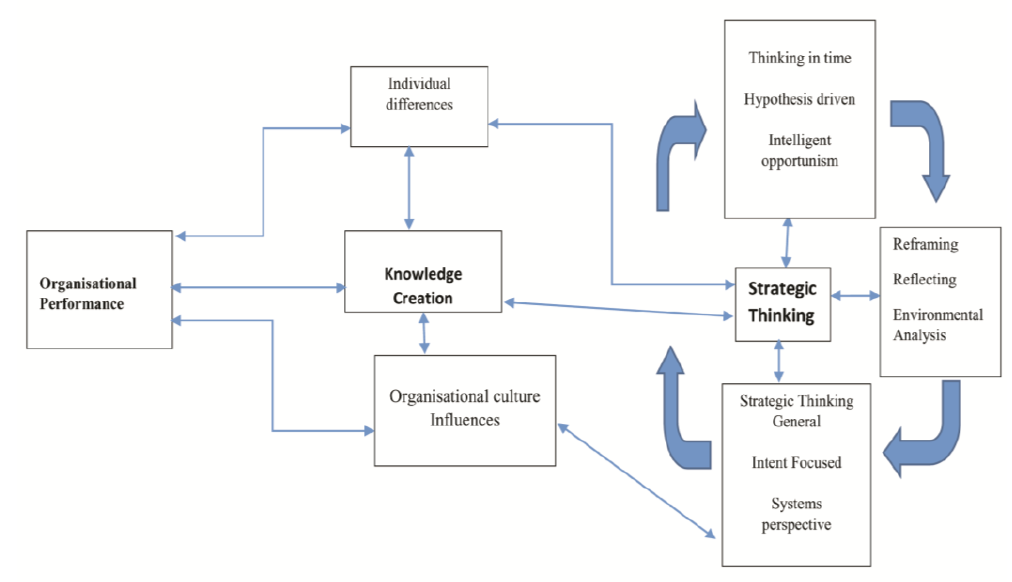
Figure 1: Modified model of learning to think strategically, Source: Casey and Goldman,